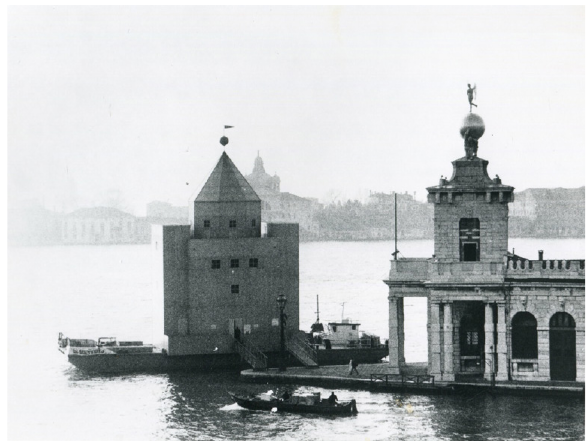
Figure 7. “Theatre of the World”, Aldo Rossi,